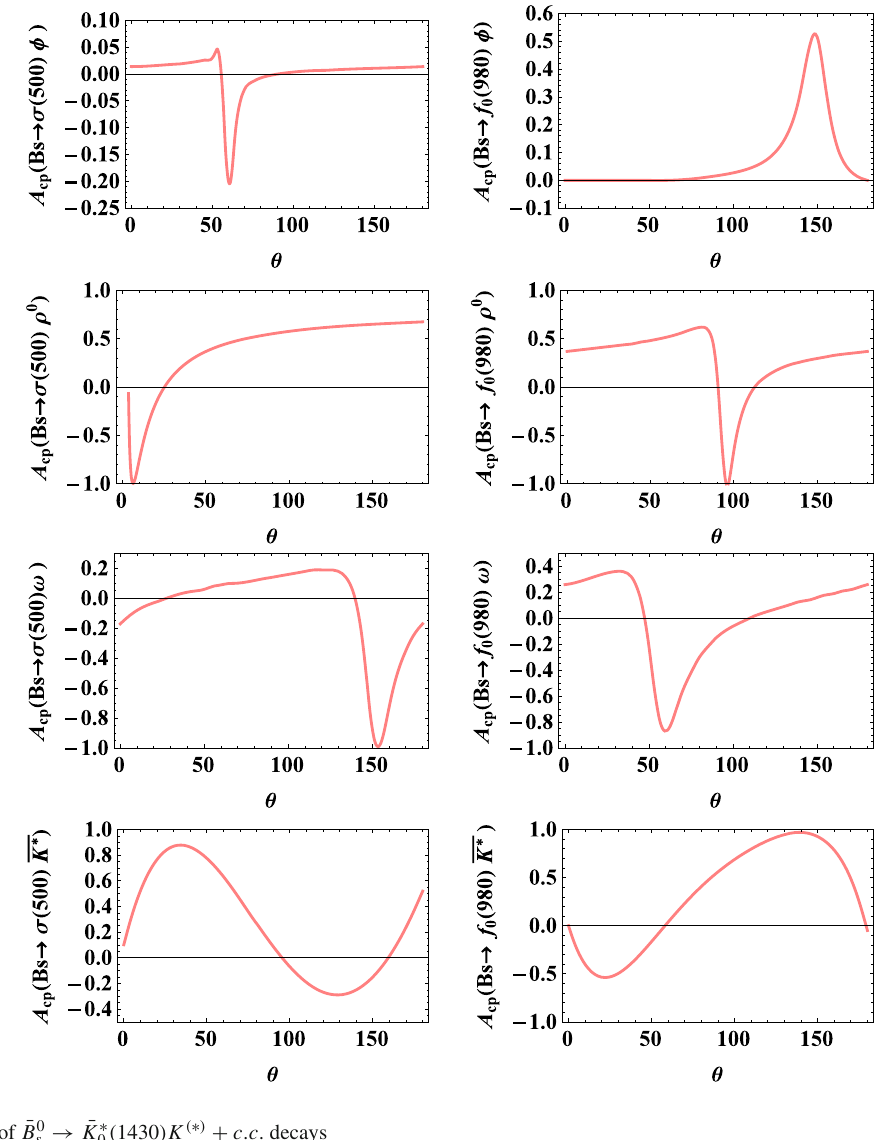
Fig. 3 The direct CP asymmetries of the B s → f 0 ( 980 ) [ σ ] V decays versus the f 0 ( 980 ) − σ mixing angle